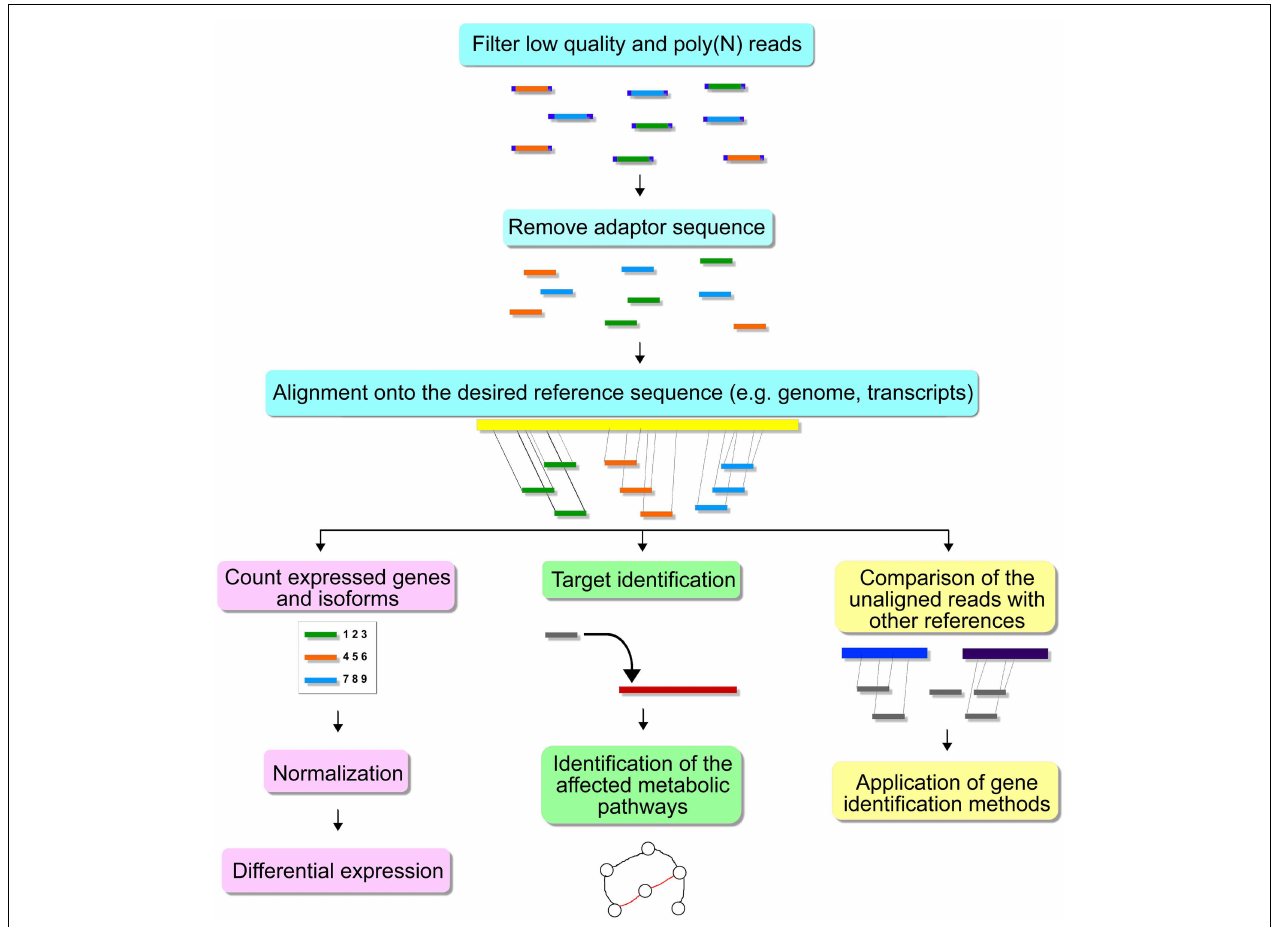
FIGURE 3 | Steps for HTS